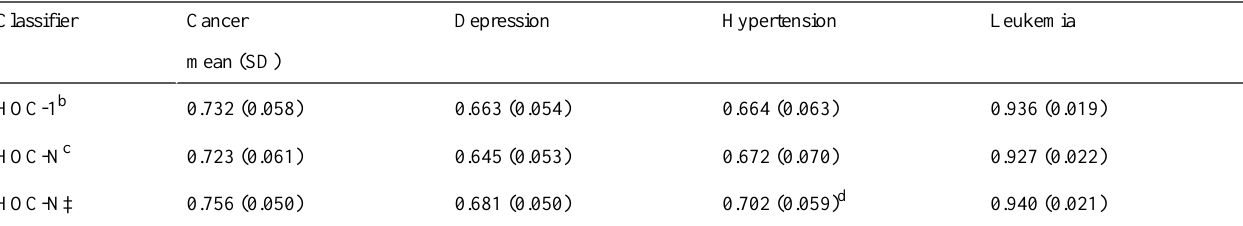
Table 5. AUPRC of homogeneous health mention classifiers, given the same number of training tweets. a